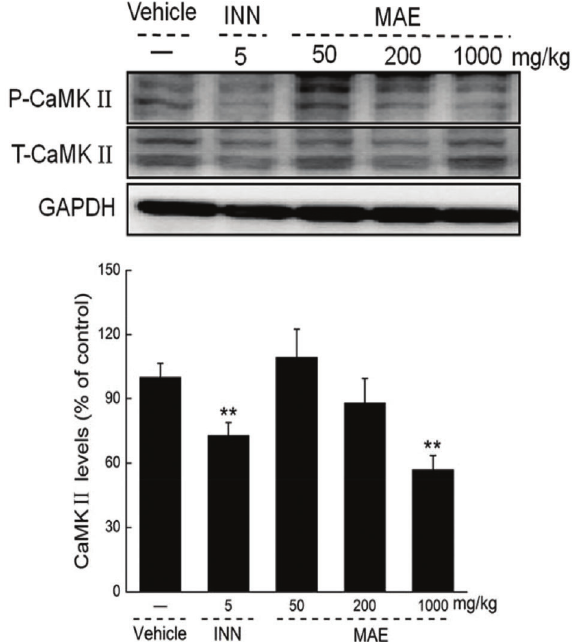
Figure 4. Mice were treated with M. androsaceus extract (MAE, 50, 200, and 1000 mg/kg) and tramadol (INN) (5 mg/kg) for 2 weeks. After 30-s thermal stimulation, the activation of CaMKII in the hypothalamus was detected via western blot. Data are reported as means ± SE (n=10). **P o 0.01 vs vehicle group (one- way ANOVA followed by Dunn ’ s